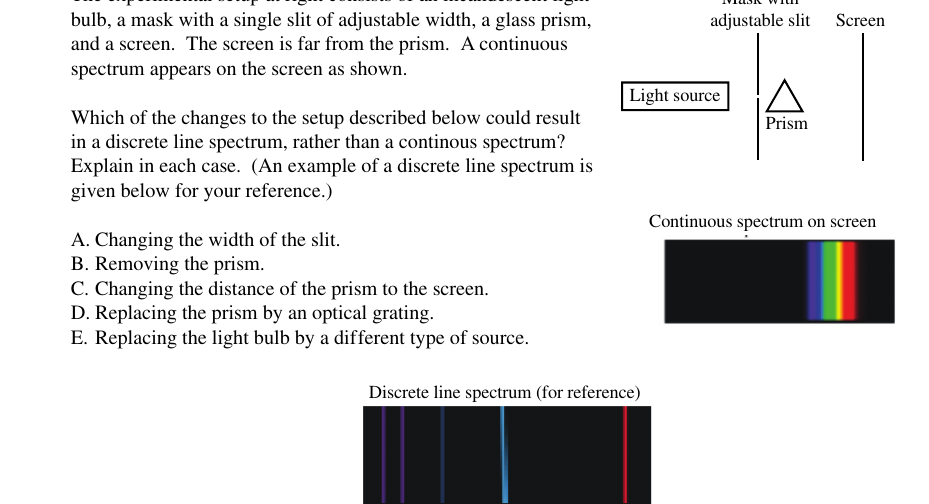
FIG. 2. Task 1. Question administered to all populations of students. In some cases, the question did not ask for explanations of